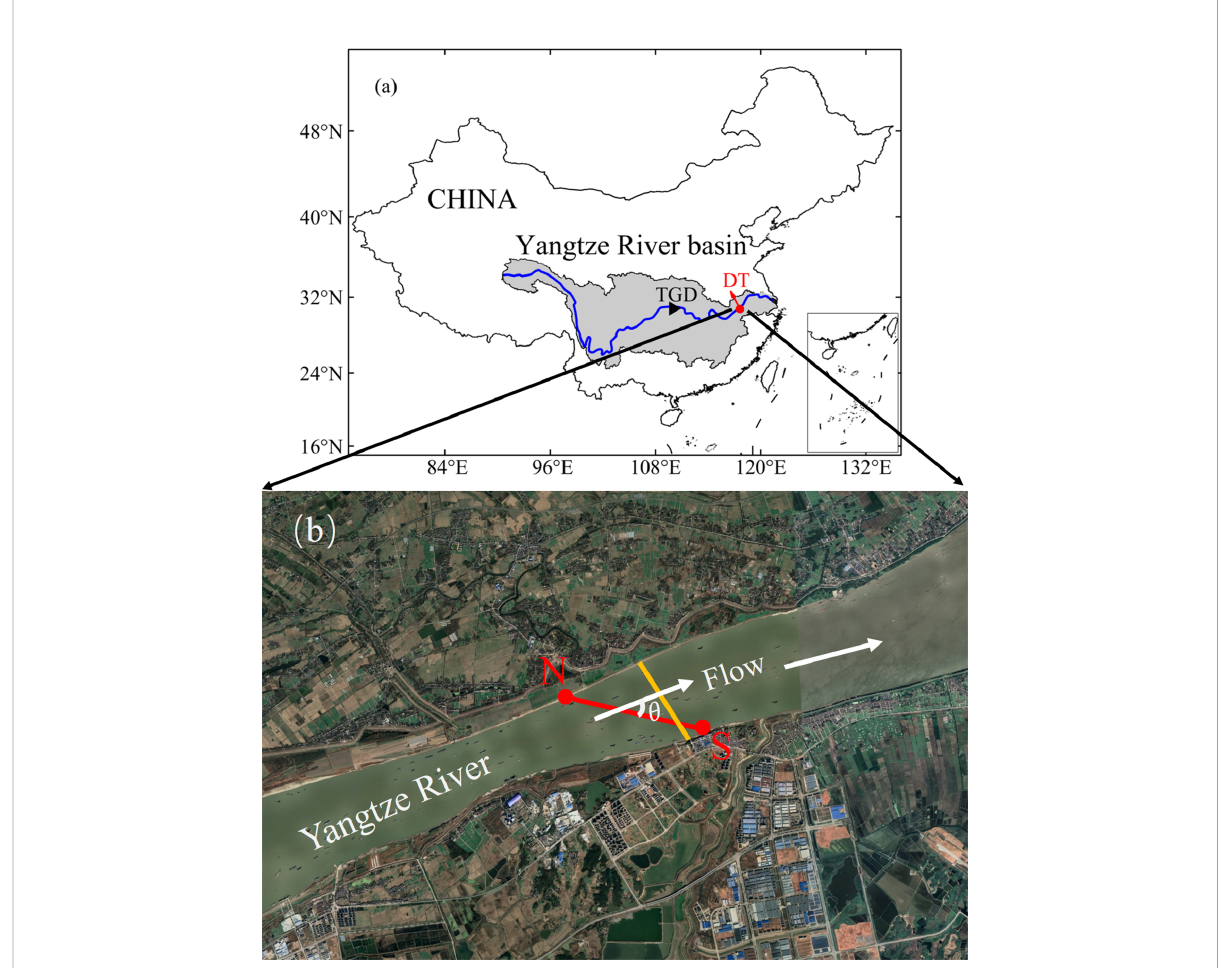
FIGURE 1 (A) Map of the Yangtze River Basin and the main channel of Yangtze River (blue line); (B) Map of the observation site and positions of two CAT stations ( N and S ), q represents the angle between the main fl ow direction and ray path of two CAT stations projected to the horizontal plane, the station S is near the Datong (DT) hydrometric station, the yellow line denotes the transect of the moving-boat ADCP. The black triangle denotes the position of the Three Gorges Dam (TGD), and the red dot denotes the location of the DT